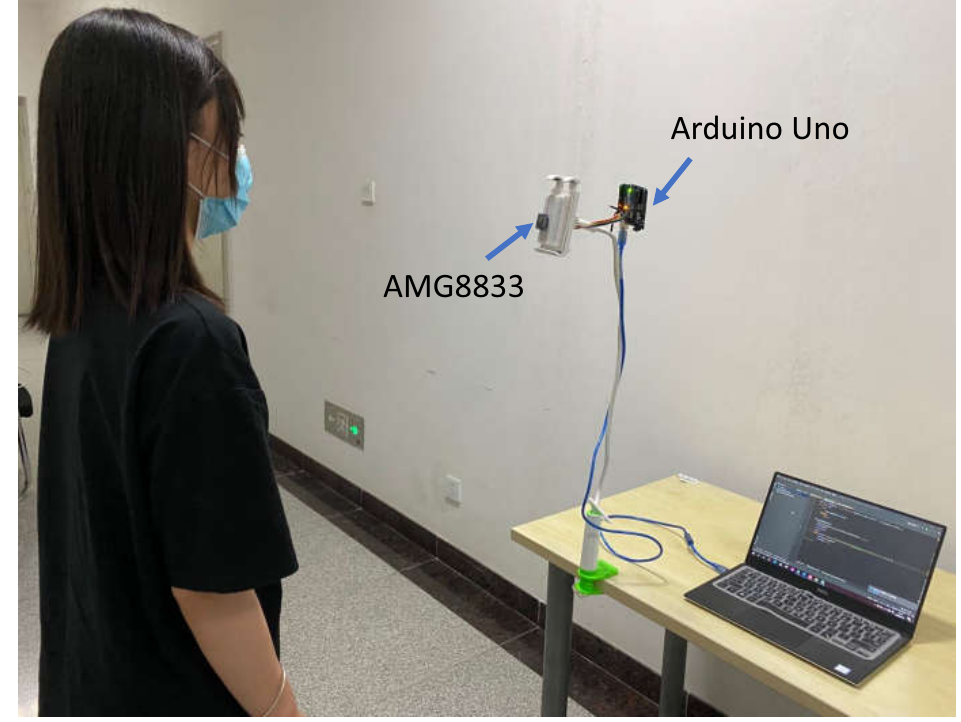
Figure 2. The experimental setup for recording the thermopile videos of a standing subject with a face